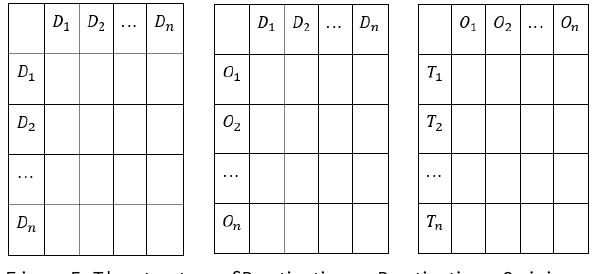
Figure 5. The structure of Destinations – Destinations, Origins – Destinations and Taxies- Origins OD